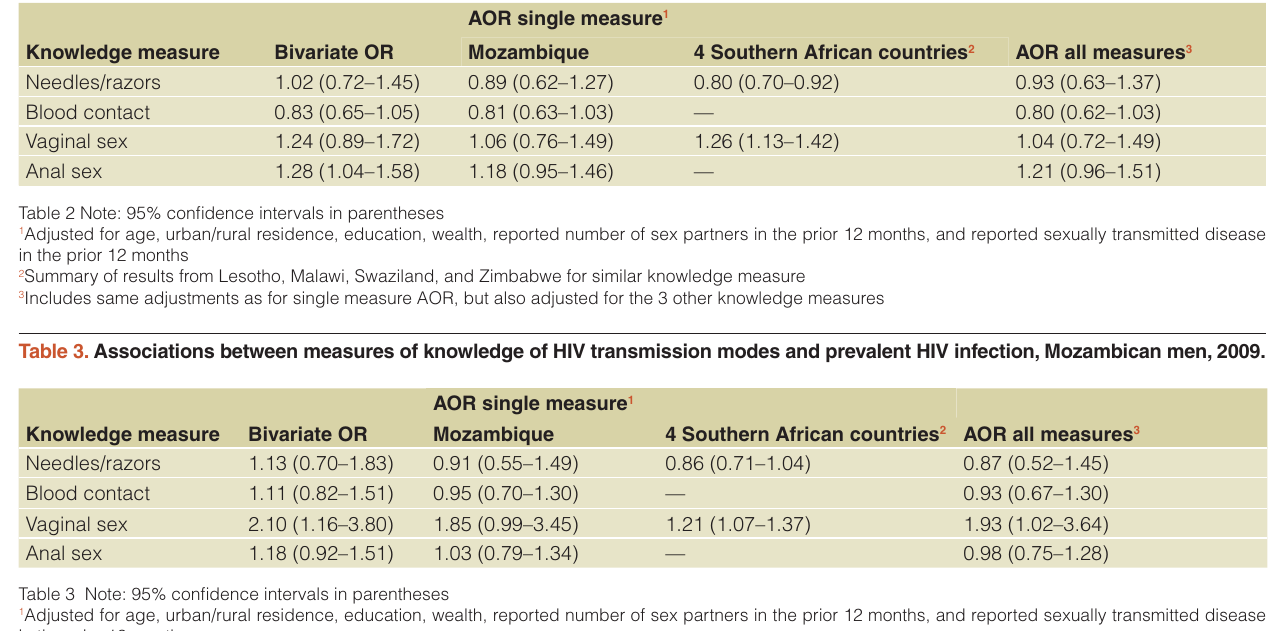
Table 3 Note: 95% confidence intervals in parentheses 1 Adjusted for age, urban/rural residence, education, wealth, reported number of sex partners in the prior 12 months, and reported sexually transmitted disease in the prior 12 months 2 Summary of results from Lesotho, Malawi, Swaziland, and Zimbabwe for similar knowledge measure 3 Includes same adjustments as for single measure AOR, but also adjusted for the 3 other knowledge measures